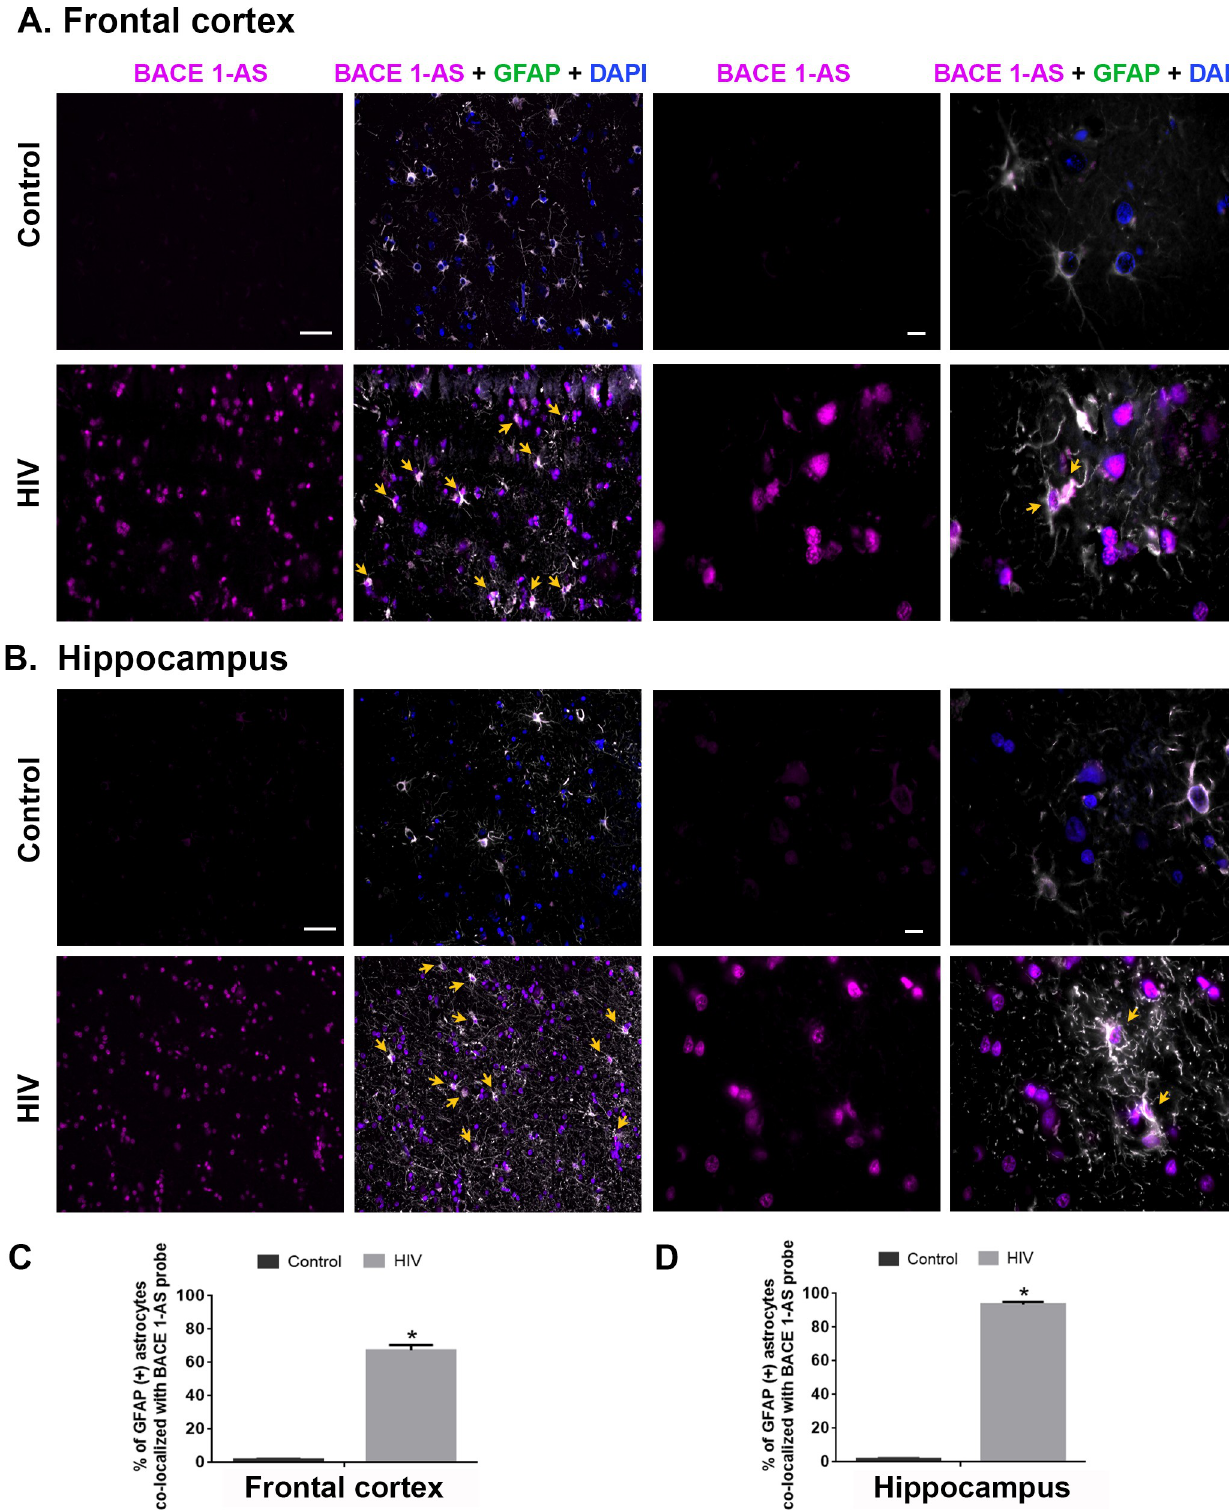
Fig 11. Region-specific expression of BACE1-AS RNA in the brains of patients infected with HIV. Representative FISH and immunofluorecence photomicrographs showing differential expression of BACE1-AS RNA in GFAP + astrocytes in the FC (A) and Hp (B) of control patients and patients who